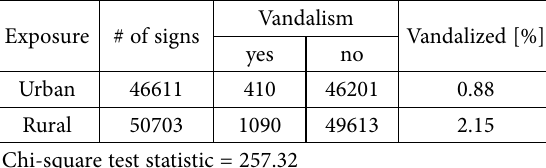
Table 6. Traffic sign vandalism by sign exposure Exposure # of signs